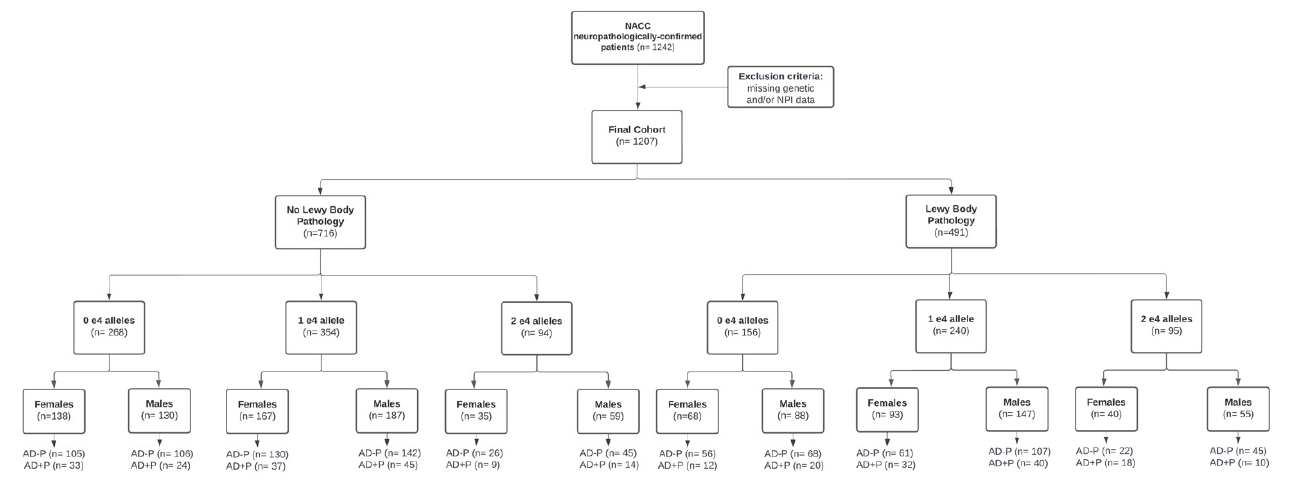
Figure 1. Cohort